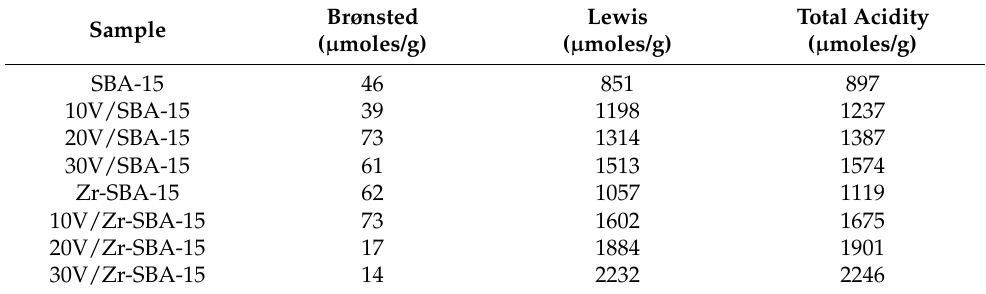
Table 2. Surface acidity data of SBA-15, Zr-SBA-15, V 2 O 5 /SBA-15, and V 2 O 5 /Zr-SBA-15 catalysts.